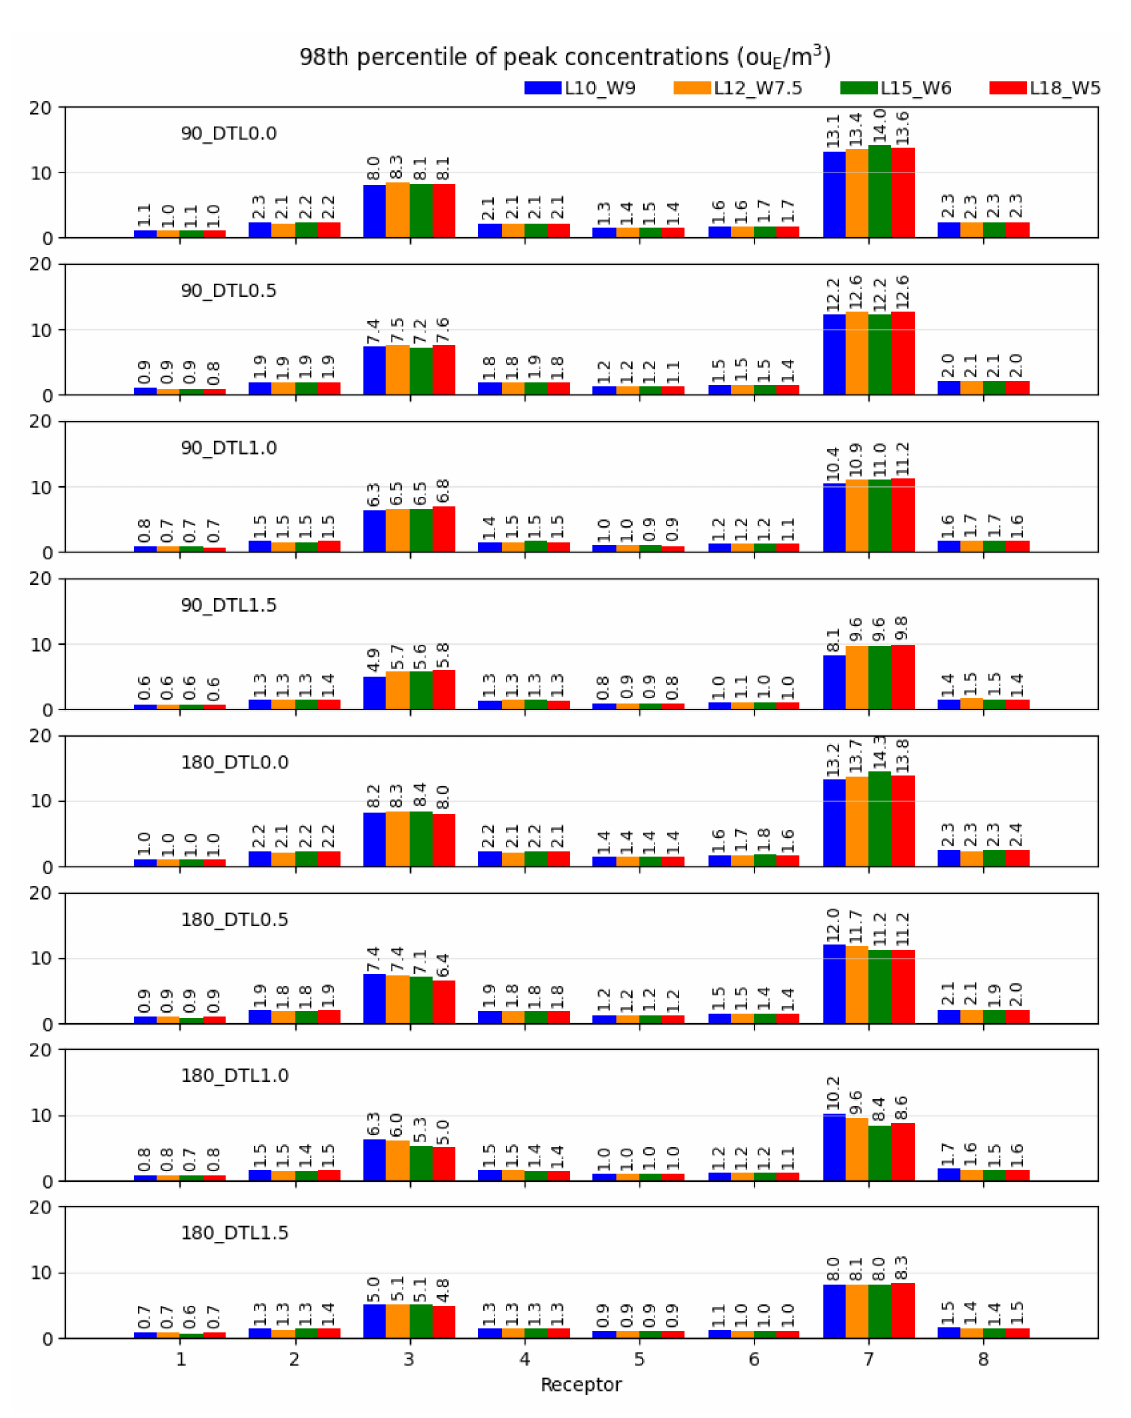
Figure 14. The 98th percentiles of peak concentrations (ouE/m 3 ) at discrete receptors for the eight emission